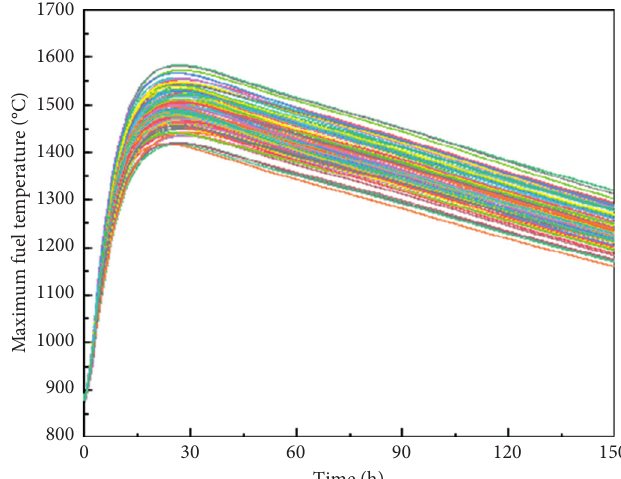
Figure 13: The time behavior of the maximum fuel temperature for the cases with uniform distributed input parameters.